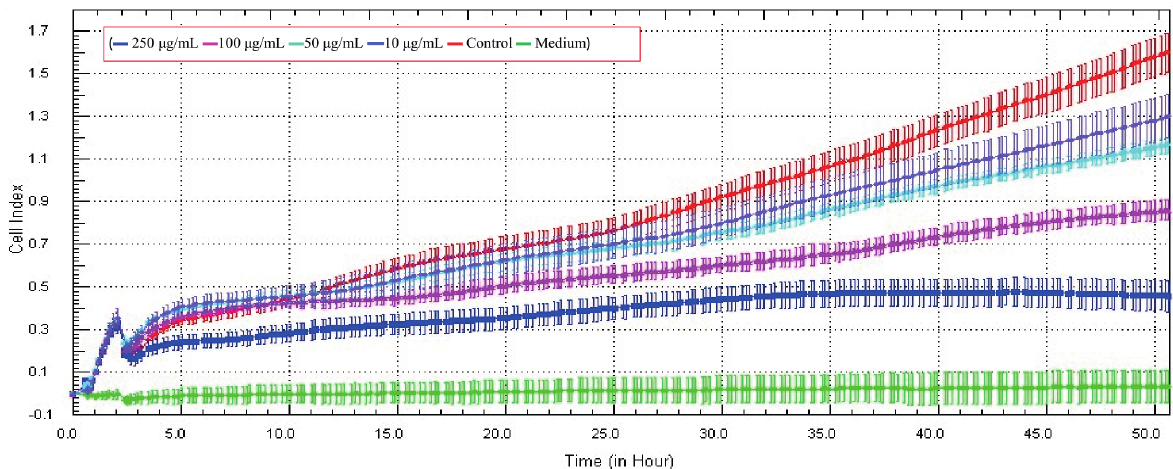
Figure 5 - In vitro antiproliferative activities of cis-platin at different concentrations indicated with colors (▬ 250 μg/mL ▬ 100 μg/mL ▬ 50 μg/mL ▬ 10 μg/mL ▬ Control ▬